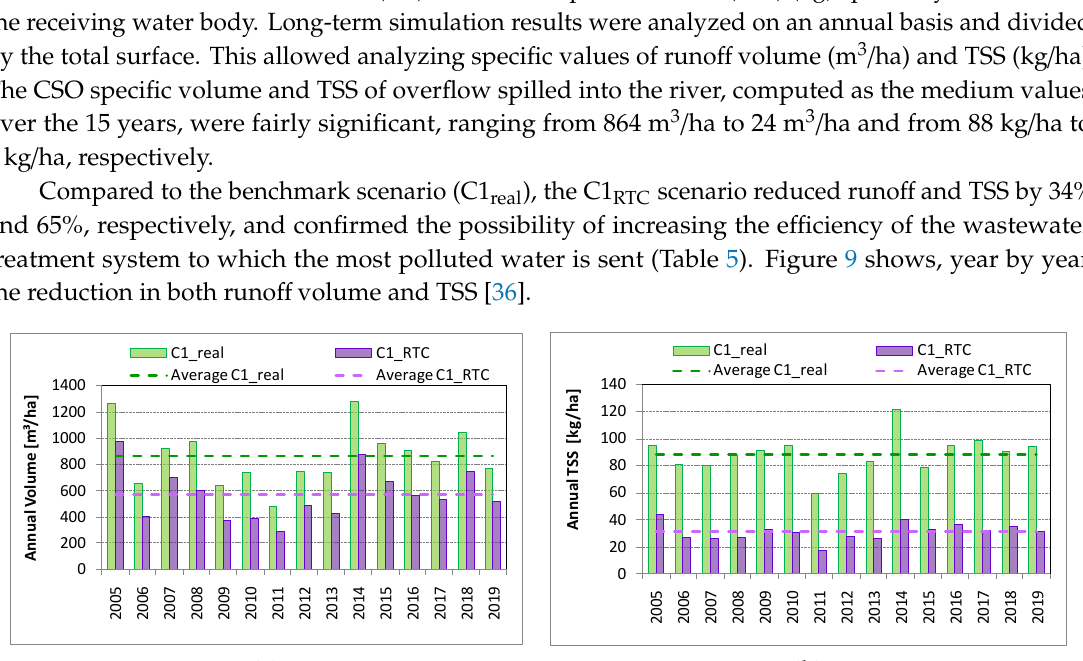
( b ) Figure 10. Annual average specific runoff volume ( a ) and annual average specific TSS ( b ) discharged by the CSO. Table 5. Simulation results in terms of specific annual average runoff volume and TSS spilled by the CSO into the receiving water body and relative percentage of reduction using C1 real as the benchmark scenario.